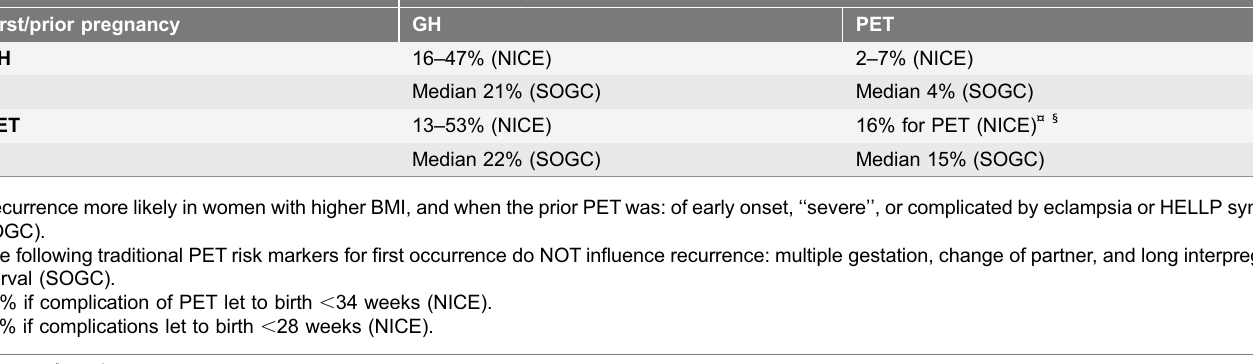
Table 5. Risks of recurrence for GH and PET reported in the NICE and SOGC guidelines.